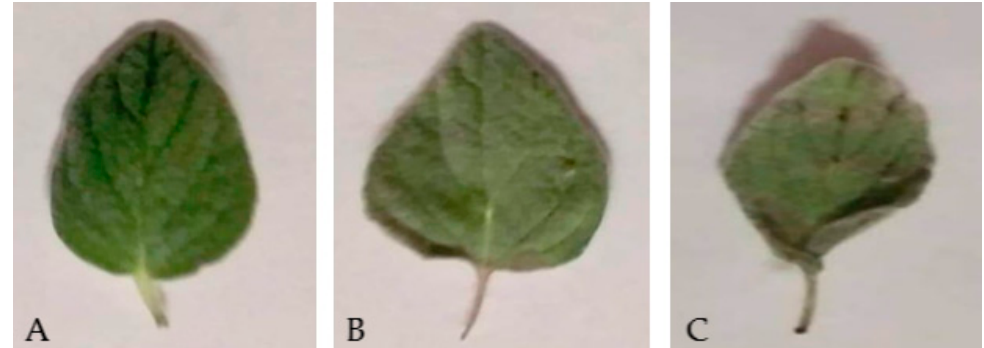
Figure 3. The morphological changes in O. syriacum leaves due to drying, ( A ) fresh, ( B ) freeze-dried, ( C ) solar dried. ( C ) solar